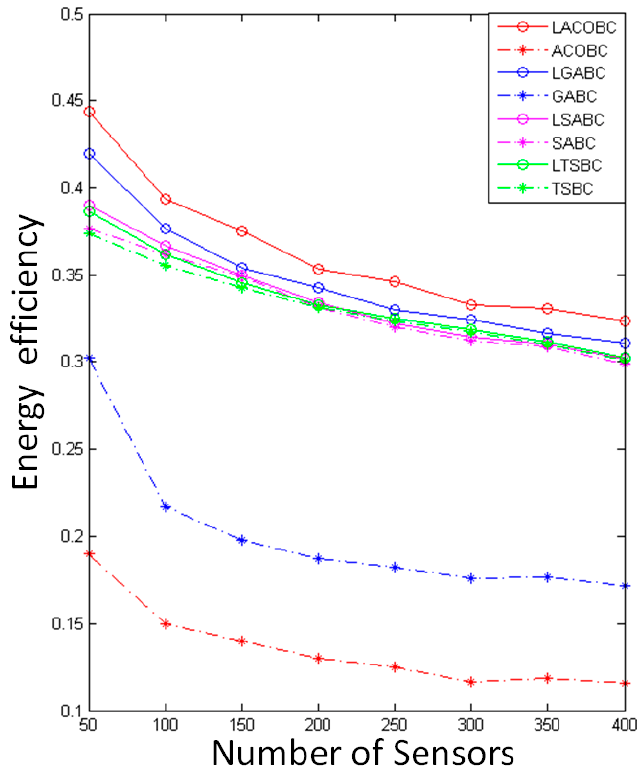
Figure 5. Comparison of energy